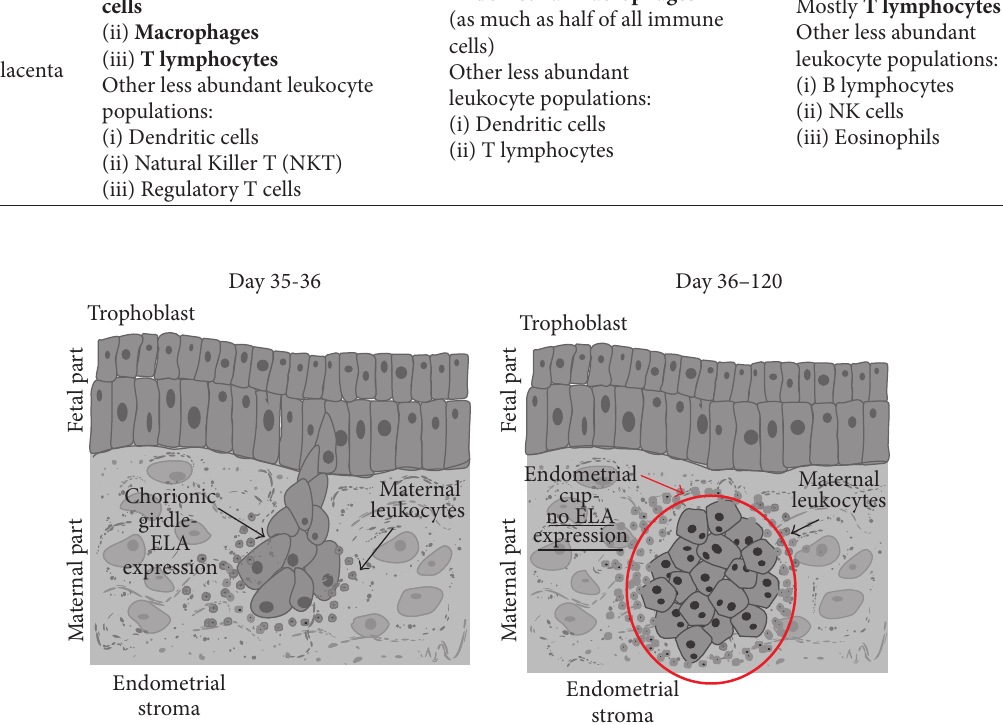
Leukocytes in placenta